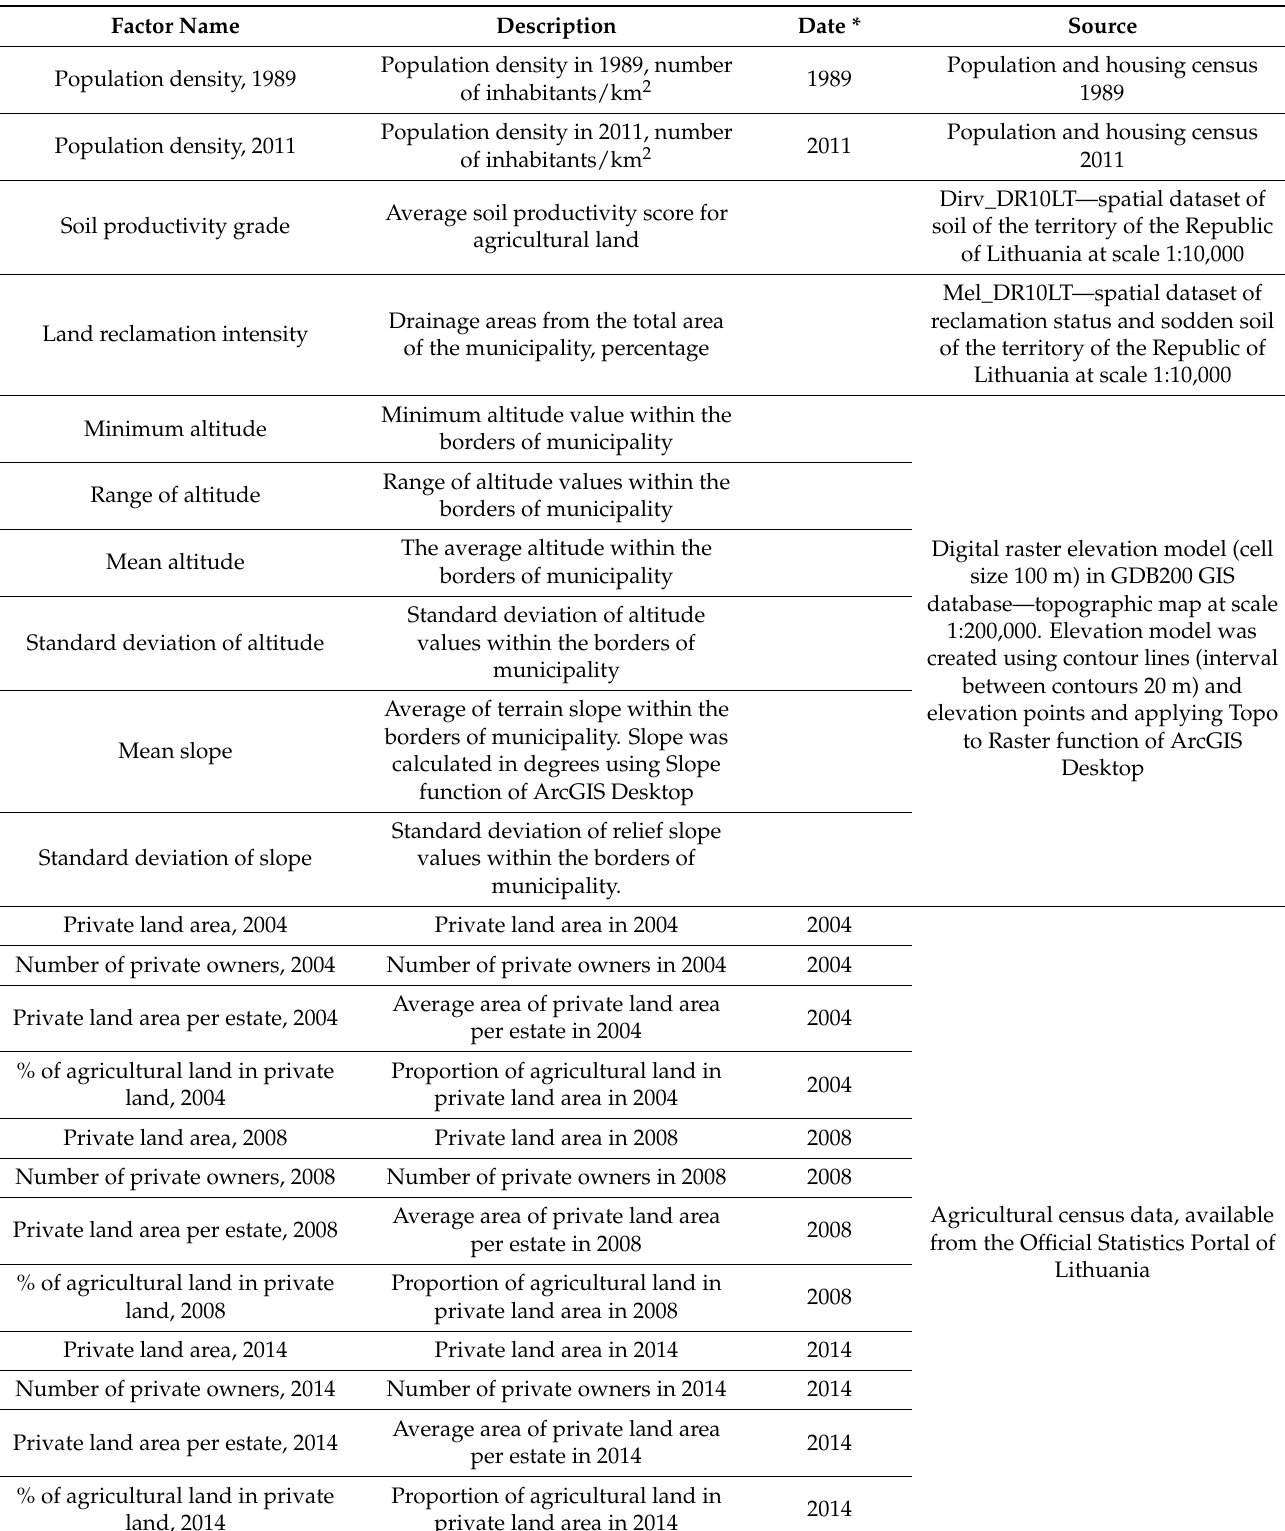
Table A1. Factors used to model land-use